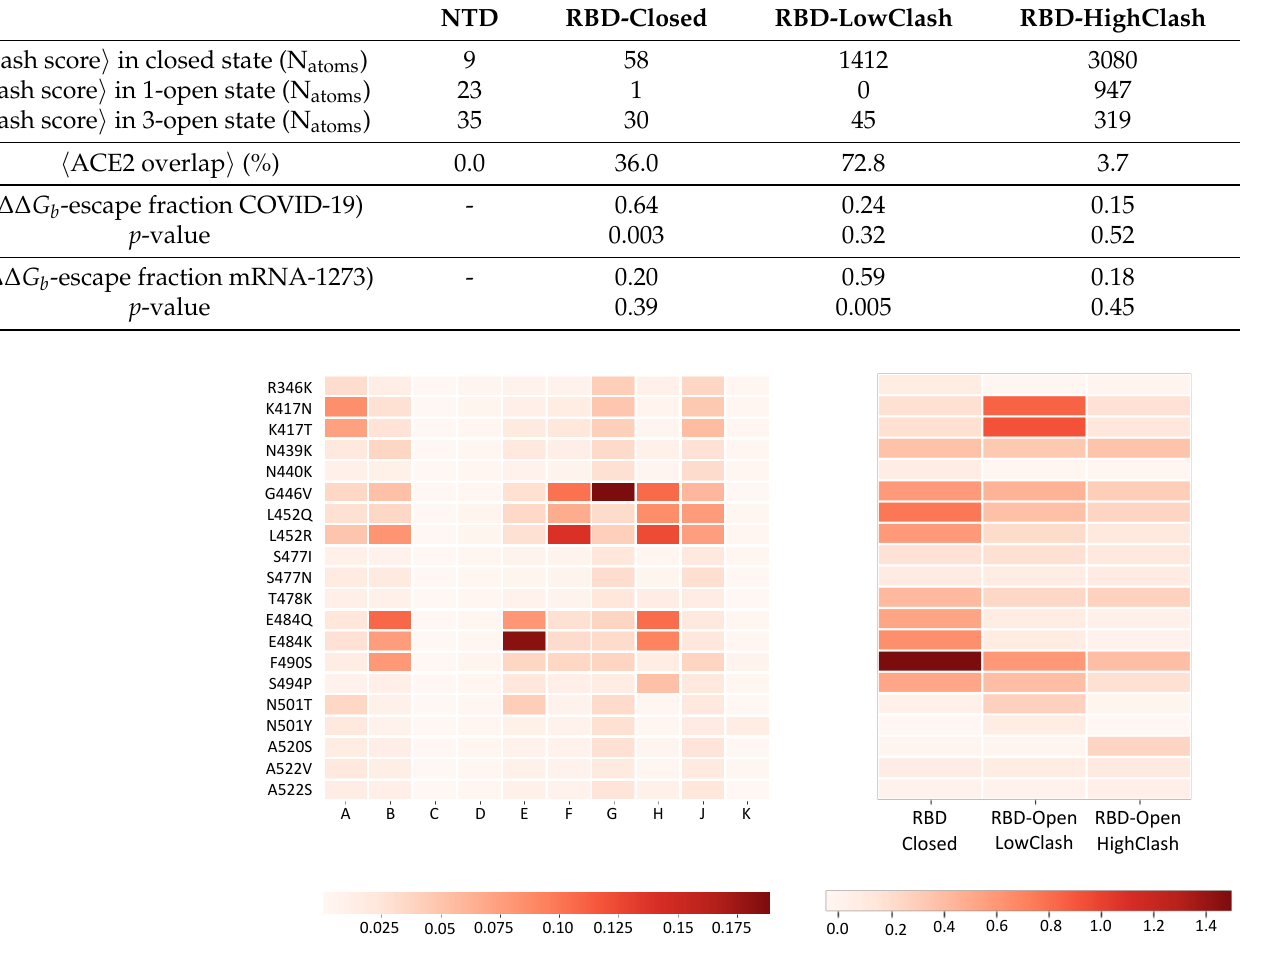
Figure 3. Heatmap in which each of the 20 rows corresponds to a variant in the receptor binding domain (RBD) (corresponding to rows 23–42 of Figure 2). Left panel: Variant escape fractions obtained from polyclonal plasma of ten COVID-19 patients noted A to K, taken from [26]. Right panel: predicted change in binding affinity upon mutation ( ∆∆ G b ) in kcal/mol for the same 20 variants, averaged over the nAb-spike protein complexes contained in the three RBD-targeting nAb classes. The escape fraction and ∆∆ G b scales are shown